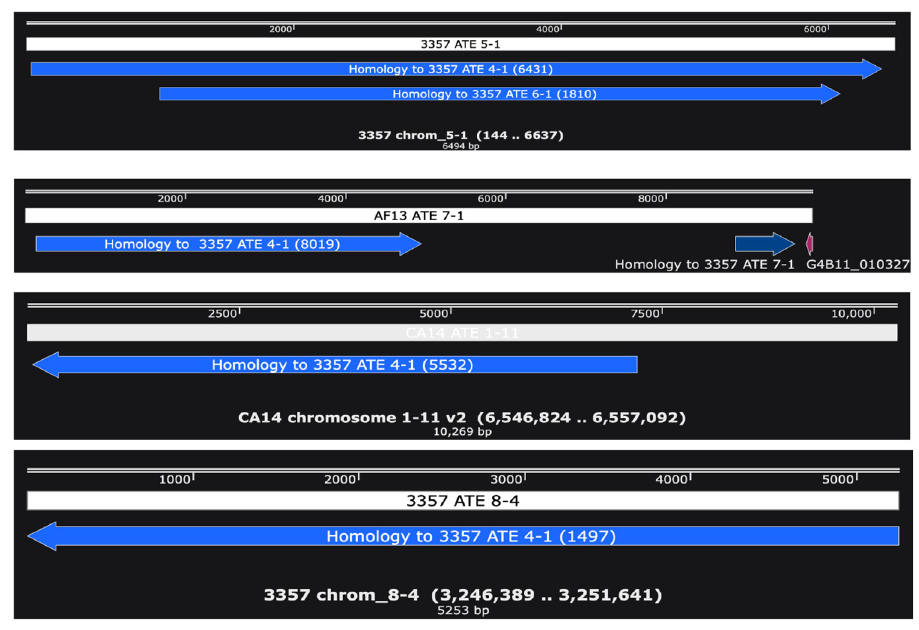
Fig 4. Defined polarity of H class elements.